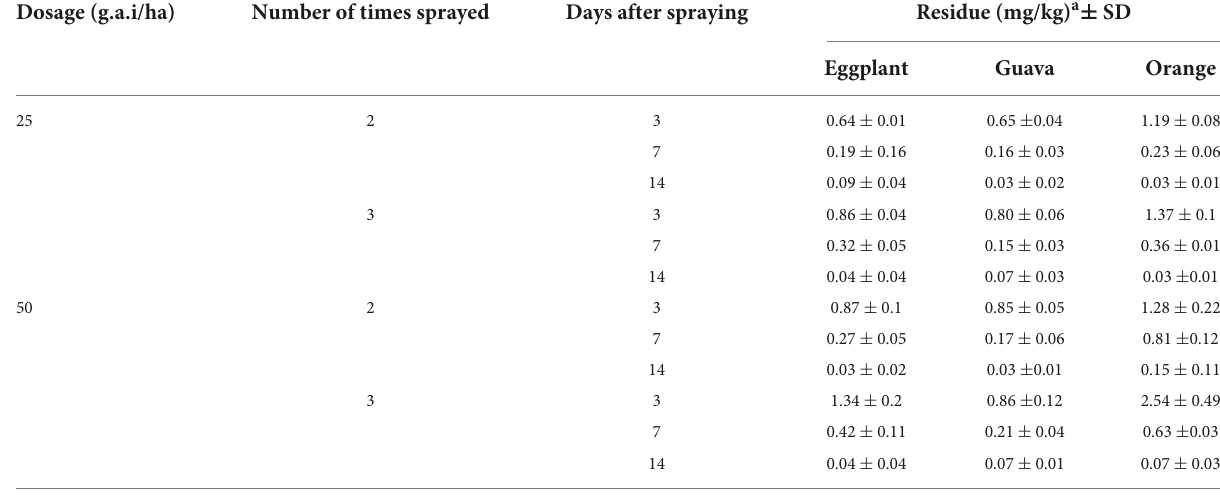
TABLE 5 Terminal residues of fenpyroximate in eggplant, guava, and orange fruits. Dosage (g.a.i/ha)